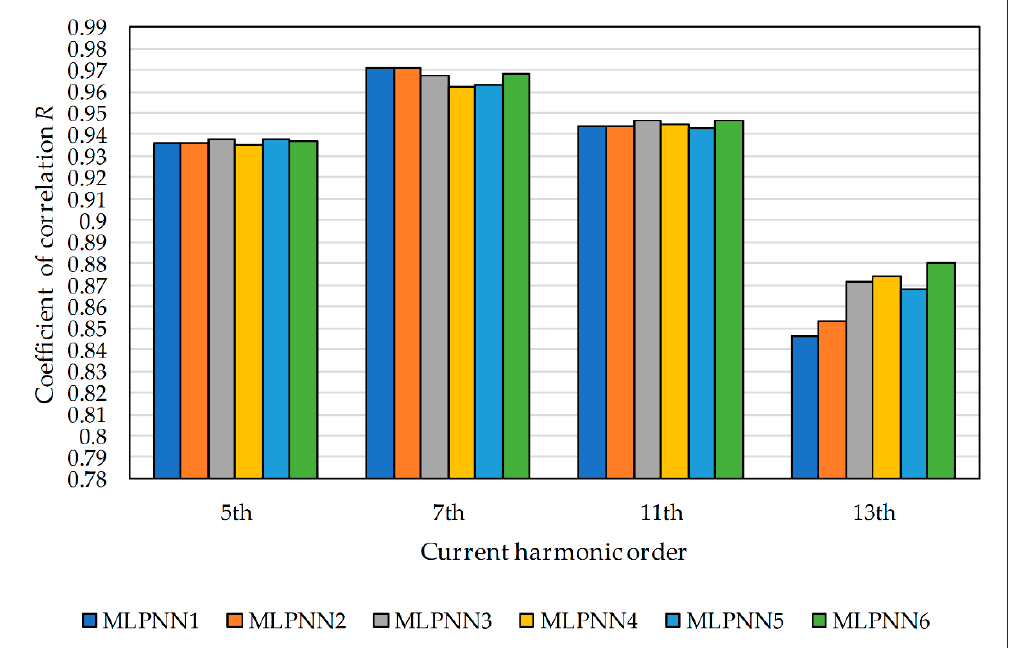
Figure 14. Coefficients of correlation R of the predictions of the 5th, 7th, 11th, and 13th current harmonics of the MLPNN models.